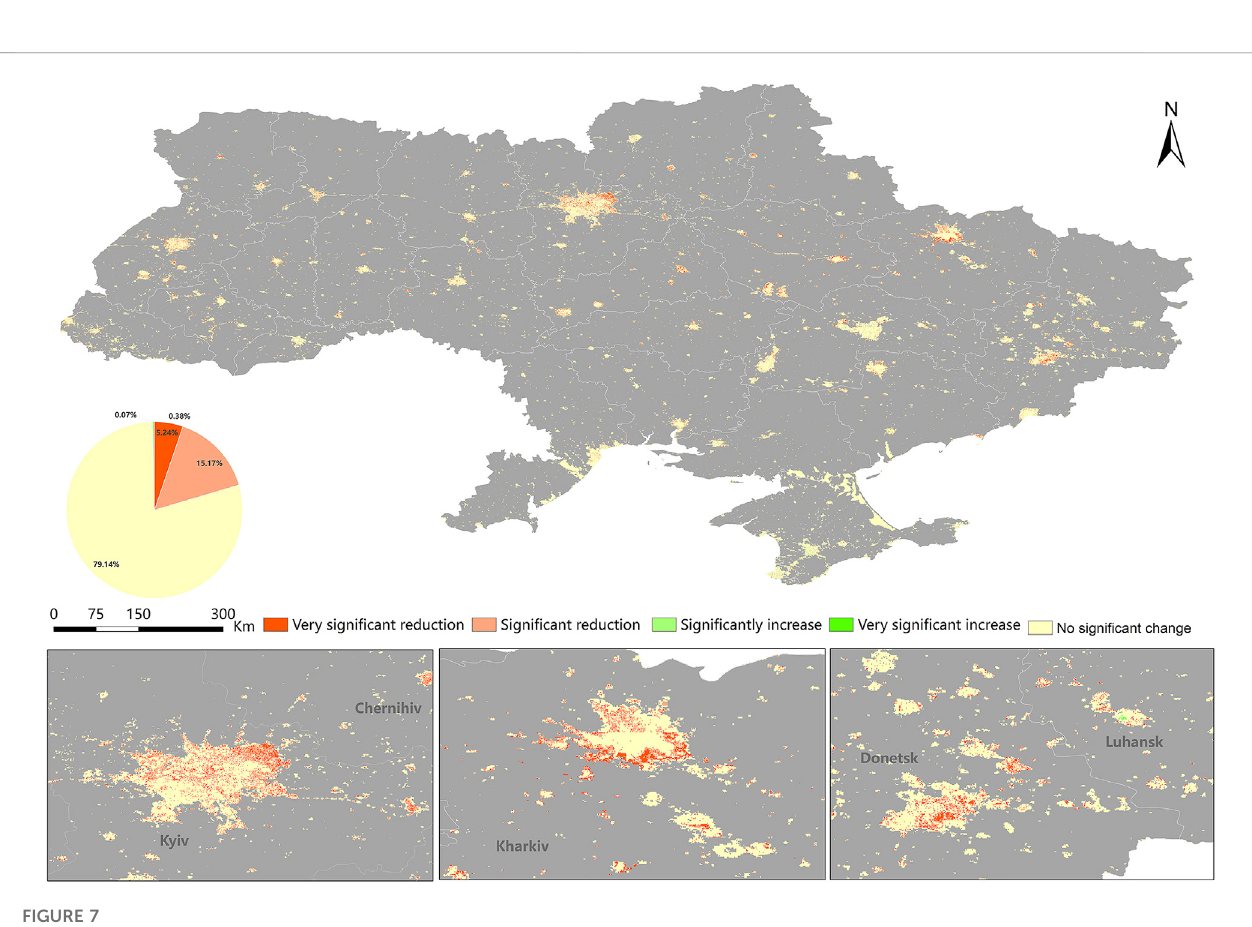
FIGURE 7 Nighttime light trends in Ukraine from 16 December 2021 to 2 May